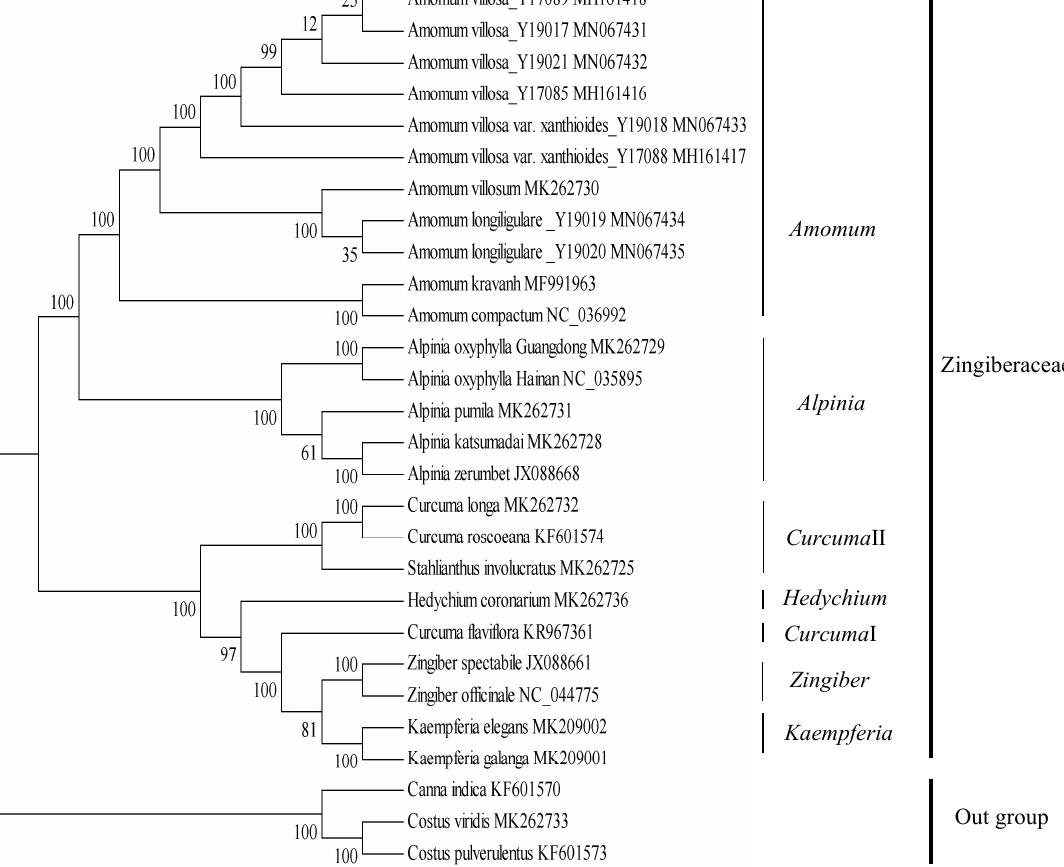
Figure 9. Phylogenetic tree constructed with SNPs from 28 chloroplast genomes using maximum likelihood method. The bootstrap values were based on 1000 replicates and were indicated next to the branches.